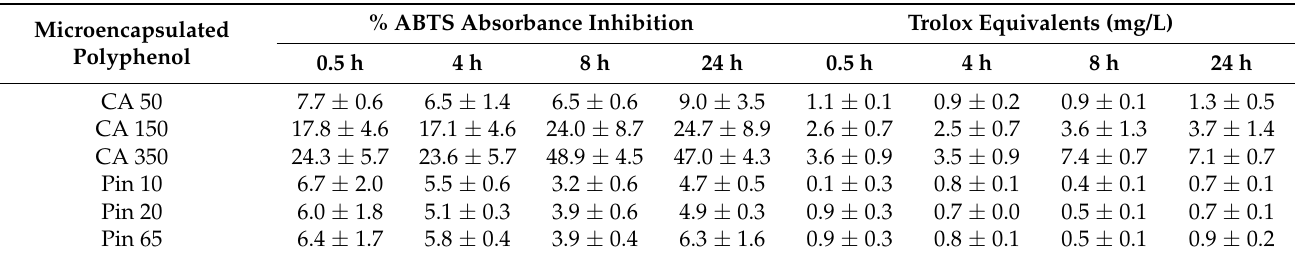
Table 2. Kinetics of the antioxidant capacity of caffeic acid and pinocembrin loaded in the nPSi- β CD composite